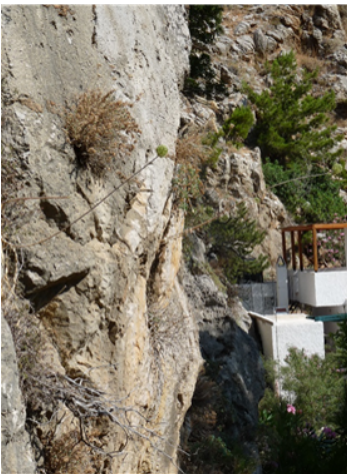
Figure 4. Allium bourgeaui ssp. bourgeaui Rech.f. (TK012; Achata beach, Karpathos) in its natural